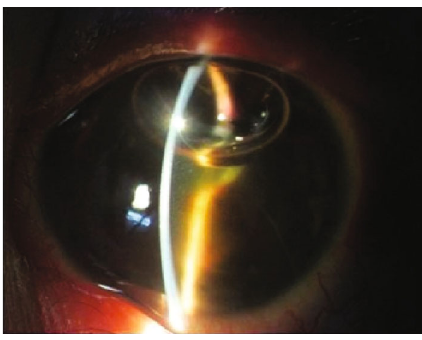
Figure 3: USG (B) scan showing multiple hyperechoic opacities in the mid and postvitreous with an attached retina.